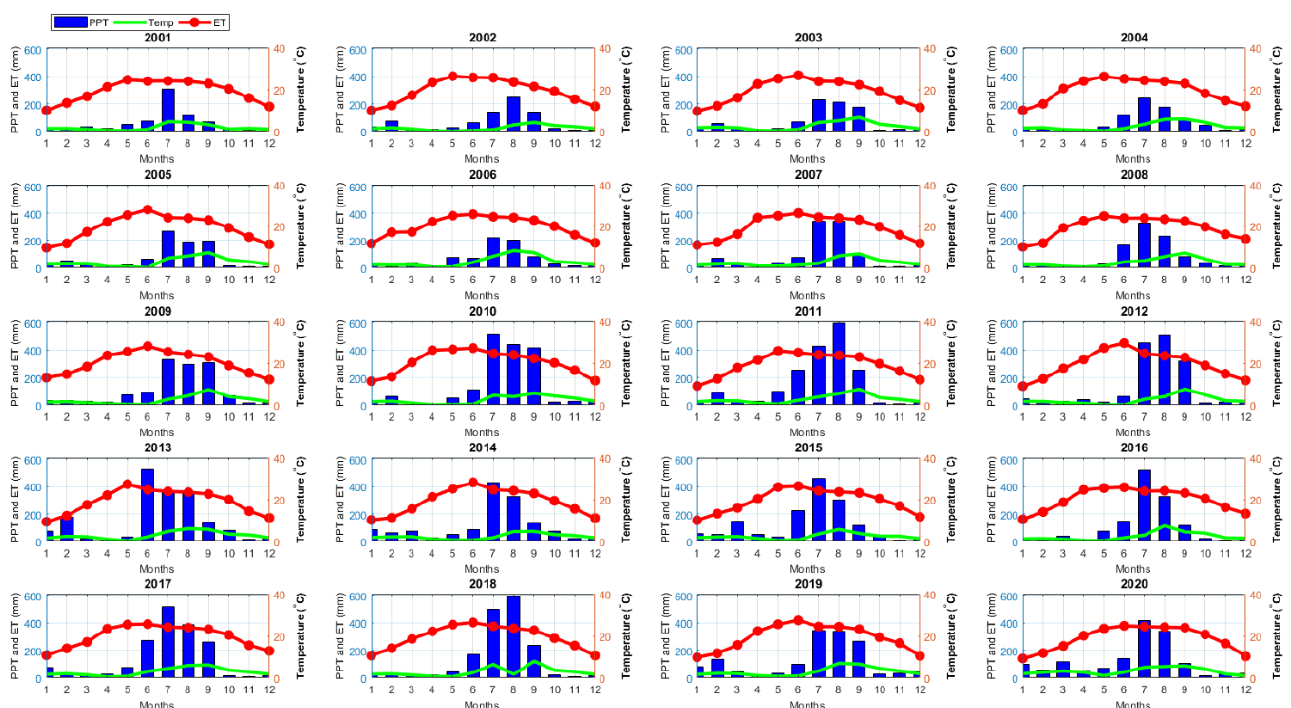
Figure 2. Inter-annual variability of precipitation (PPT) in mm, temperature in °C, and evapotranspiration (ET) in mm over twenty years (2001–2020) for the UKR Basin. Note that 1–12 on the x -axis represent the months from January to December.